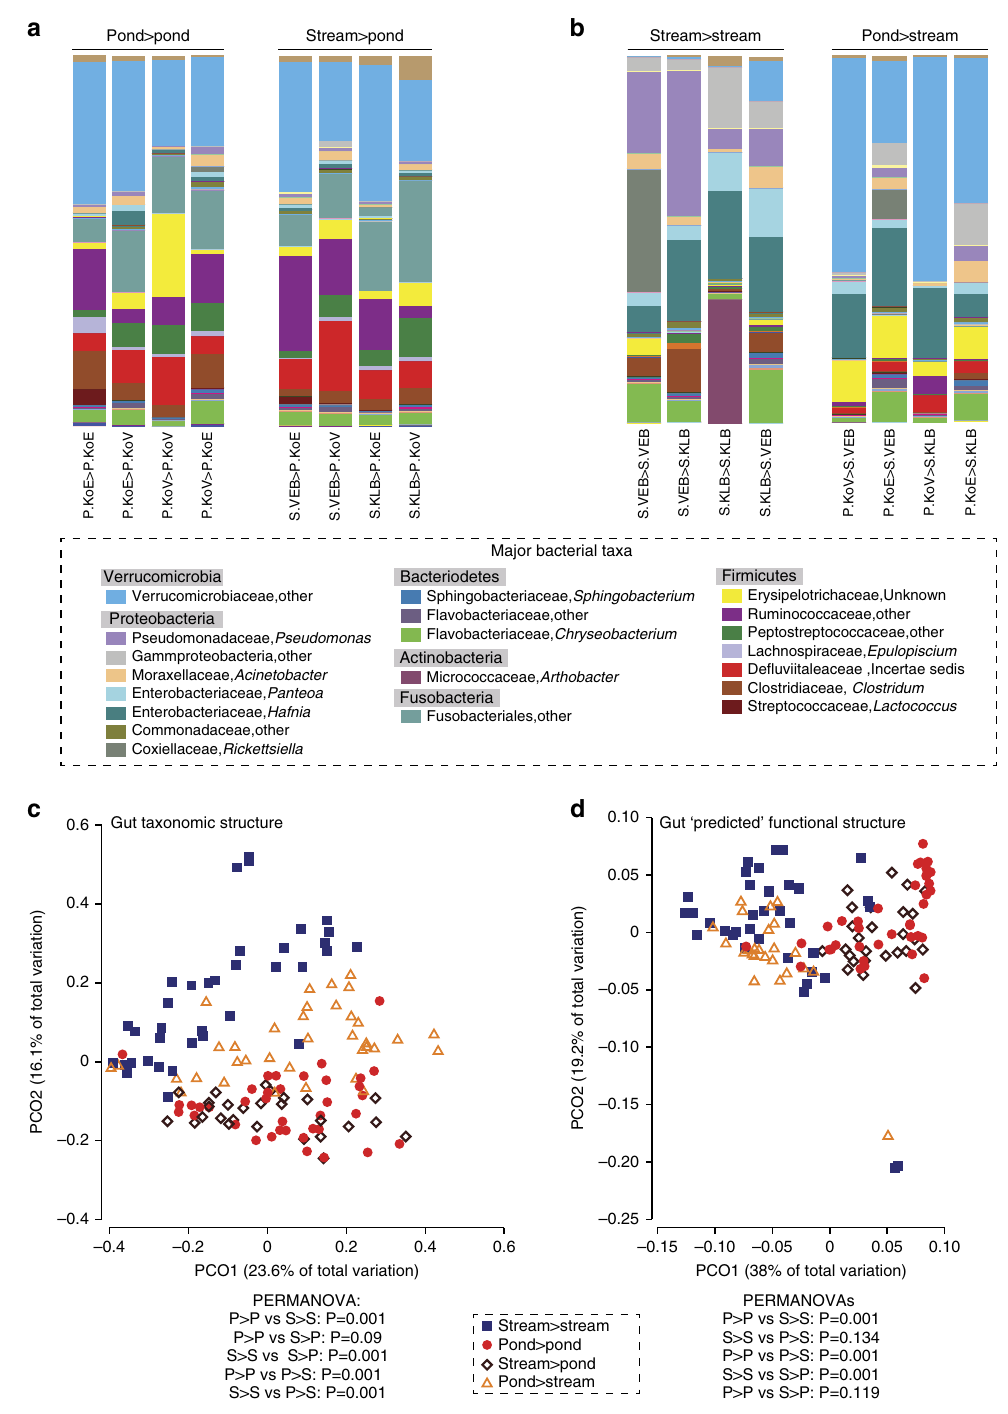
Figure 4 | Gut bacterial community structure and predicted functions in response to habitat transfer. a b show mean relative abundance profiles of Core50 OTUs in the gut bacterial communities of larvae at the genus level. a shows larvae derived from streams and transferred to ponds in comparison with PP controls. b shows larvae derived from ponds and transferred to streams in comparison with SS controls. c shows Principle Coordinate Analysis of unweighted Unifrac distance matrices of the Core50 communities of larvae in the transfer experiment. d shows PCo analyses of predicted functional profiles of gut bacterial communities from larvae in the transfer experiment. Functional PCoA visualisations are based on Bray-Curtis distance matrices. Sample Sizes were: n ¼ 36 (SS, blue squares), n ¼ 38 (PP; red circles), n ¼ 27 (SP; brown open squares), n ¼ 36 (PS; yellow open triangles). Pair-wise PERMANOVA results are displayed below each PCoA. PERMDISP showed that P 4 S differed in dispersion from S 4 S ( t ¼ 5.0108 P ¼ 0.001), but S 4 P did not differ from P 4 P ( t ¼ 0.80695 P ¼ 0.431). Note that larvae transferred from PS become distinct from PP individuals and SS individuals, ( b , c ) whereas larval transferred from SP fully diverge from the bacterial communities of SS individuals and become identical (that is, not significantly different from) to PP larvae ( a , c ). For the predicted functions, however, both transfer groups switched to make that of the destination habitat controls ( d